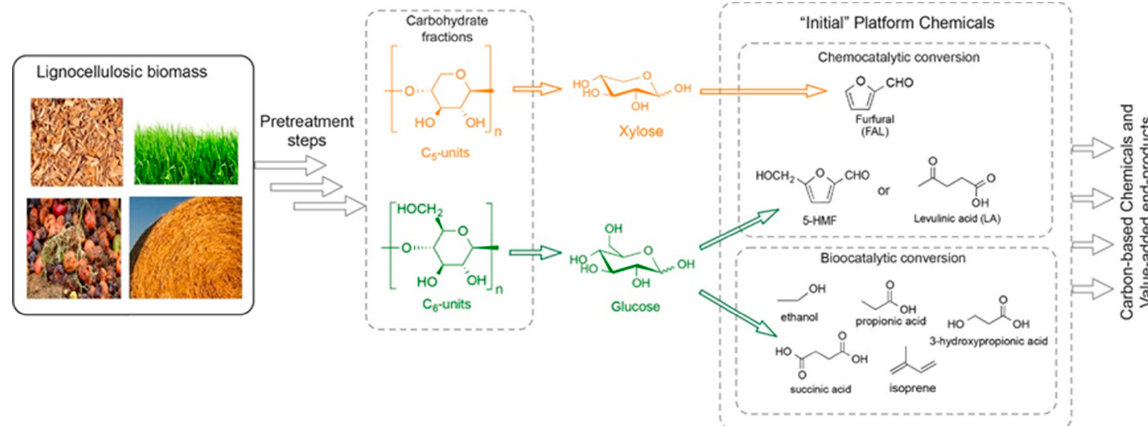
Figure 1. Biorefining scheme for the upgrading of lignocellulosic biomass into value-added platform chemicals and liquid fuels [19]. Reproduced with permission from Ref. [19].